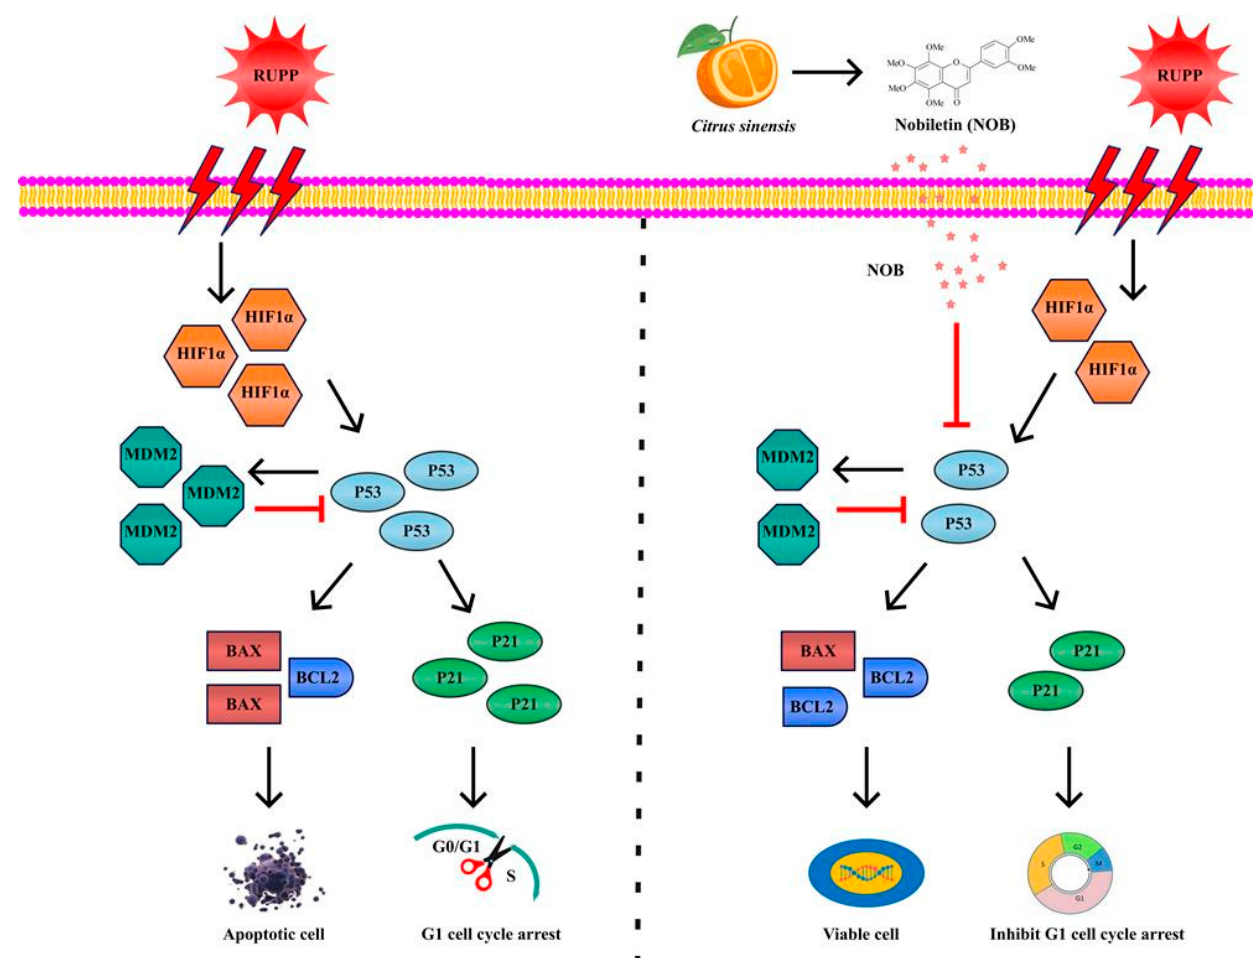
Figure 6. Putative mechanism of NOB’s inhibiting effect on RUPP-induced placental damage. NOB reduced the level of P53 in the placenta of RUPP rats, thereby inhibiting the apoptosis and relieving G1 cell cycle arrest.